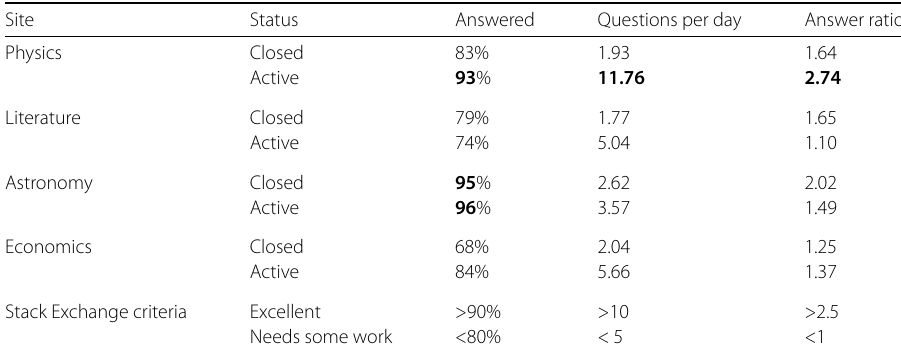
Table 1 Community overview for first 180 days according to SE evaluation criteria